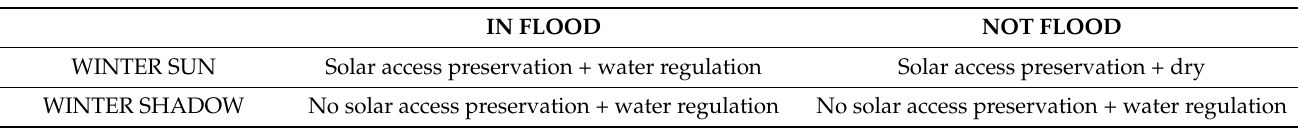
Table 1. The four co-conditions informing tree selection criteria when overlaying the flood and overshadow